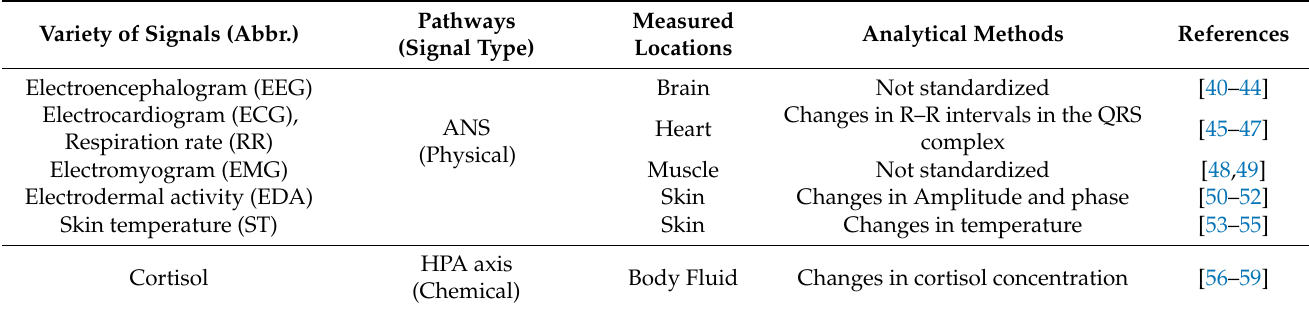
Table 1. Representative biomarkers utilized to measure stress